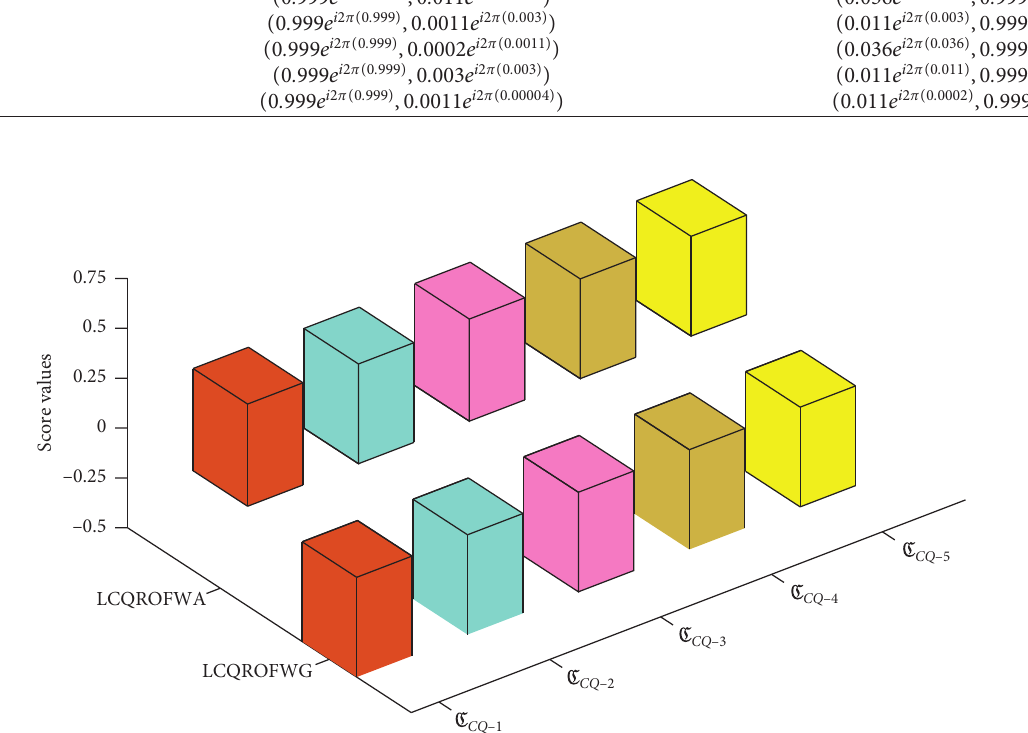
Figure 1: Geometrical representation of the score values for Example